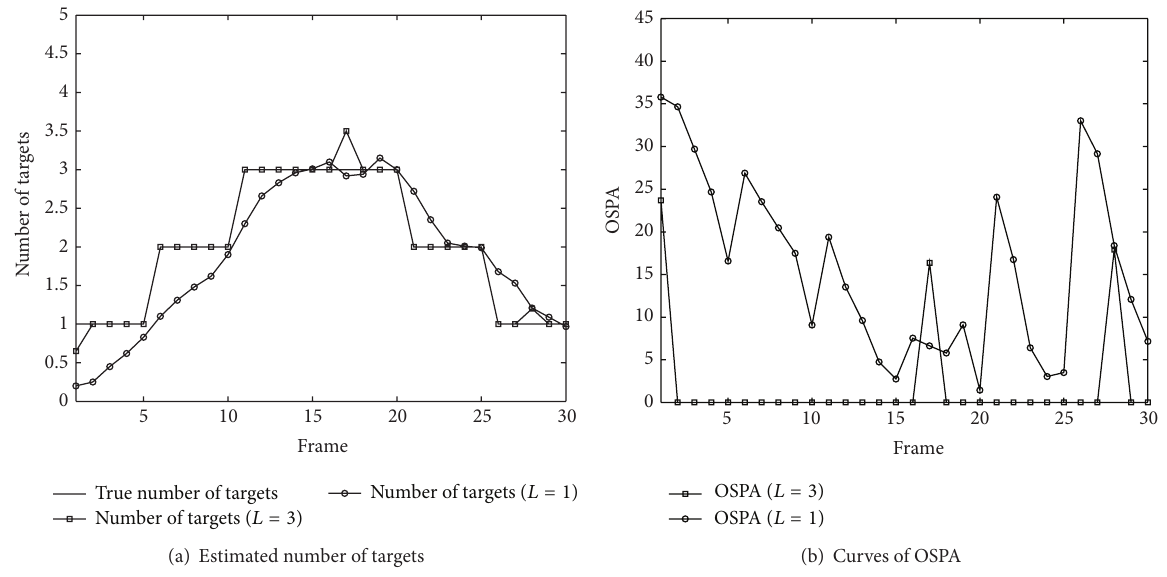
Figure 8: The estimated number of targets and OSPA (SNR = 8.7 dB).